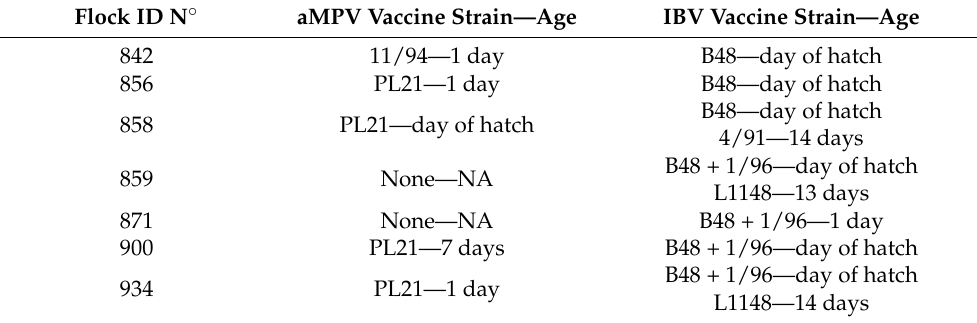
Table 1. Vaccination programs applied in broiler flocks enrolled in the study.